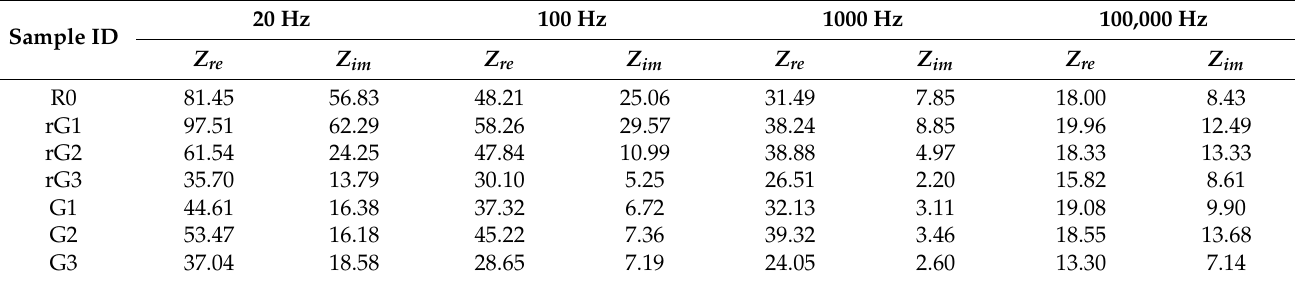
Figure 13. Impedance responses of the samples with rGO ( a ) and GO ( b ) addition. Table 5. Impedance values of the samples at specific frequencies (k Ω